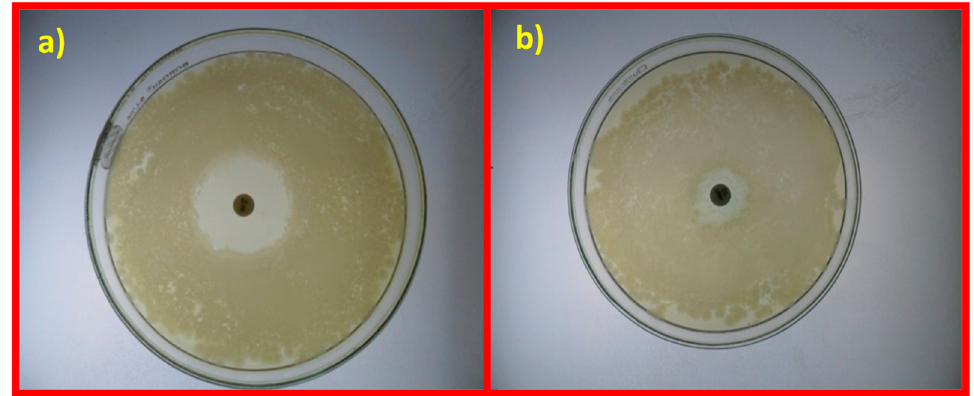
Figure 6. Antibiotic sensitivity test for Pseudomonas pneumonia ( a ) and Staphylococcus aureus ( b ) with erythromycin.